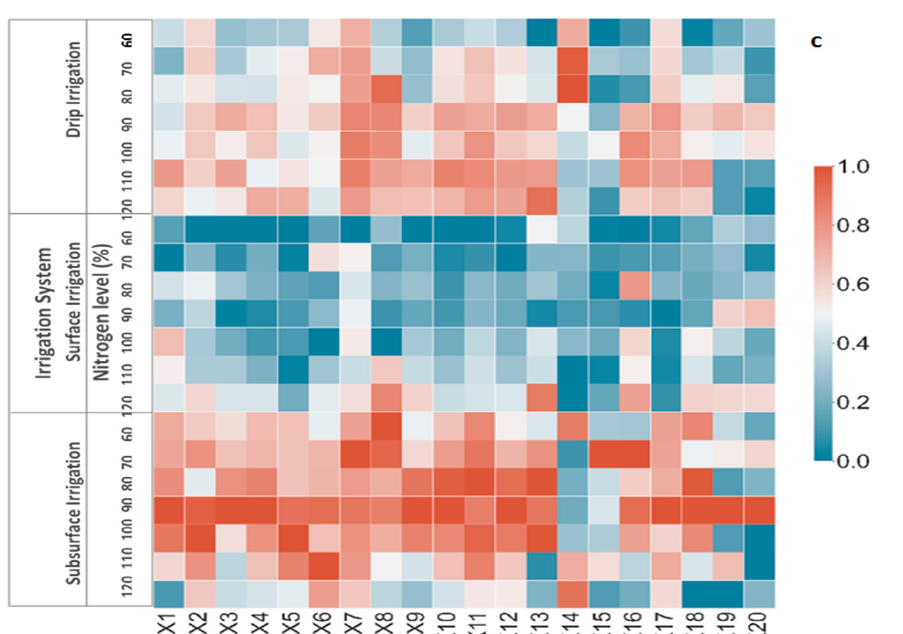
Figure 3. The normalized values (0–1) of the plant measurements (X1–X20) response to the different applied nitrogen levels (%) and irrigation systems at seasons 2019 ( a ), 2020 ( b ), and the average of both seasons ( c ). Note: X1:PL, X2:L NO P, X3:LA, X4:LFW, X5:L D W, X6:SPAD, X7:PROLINE,